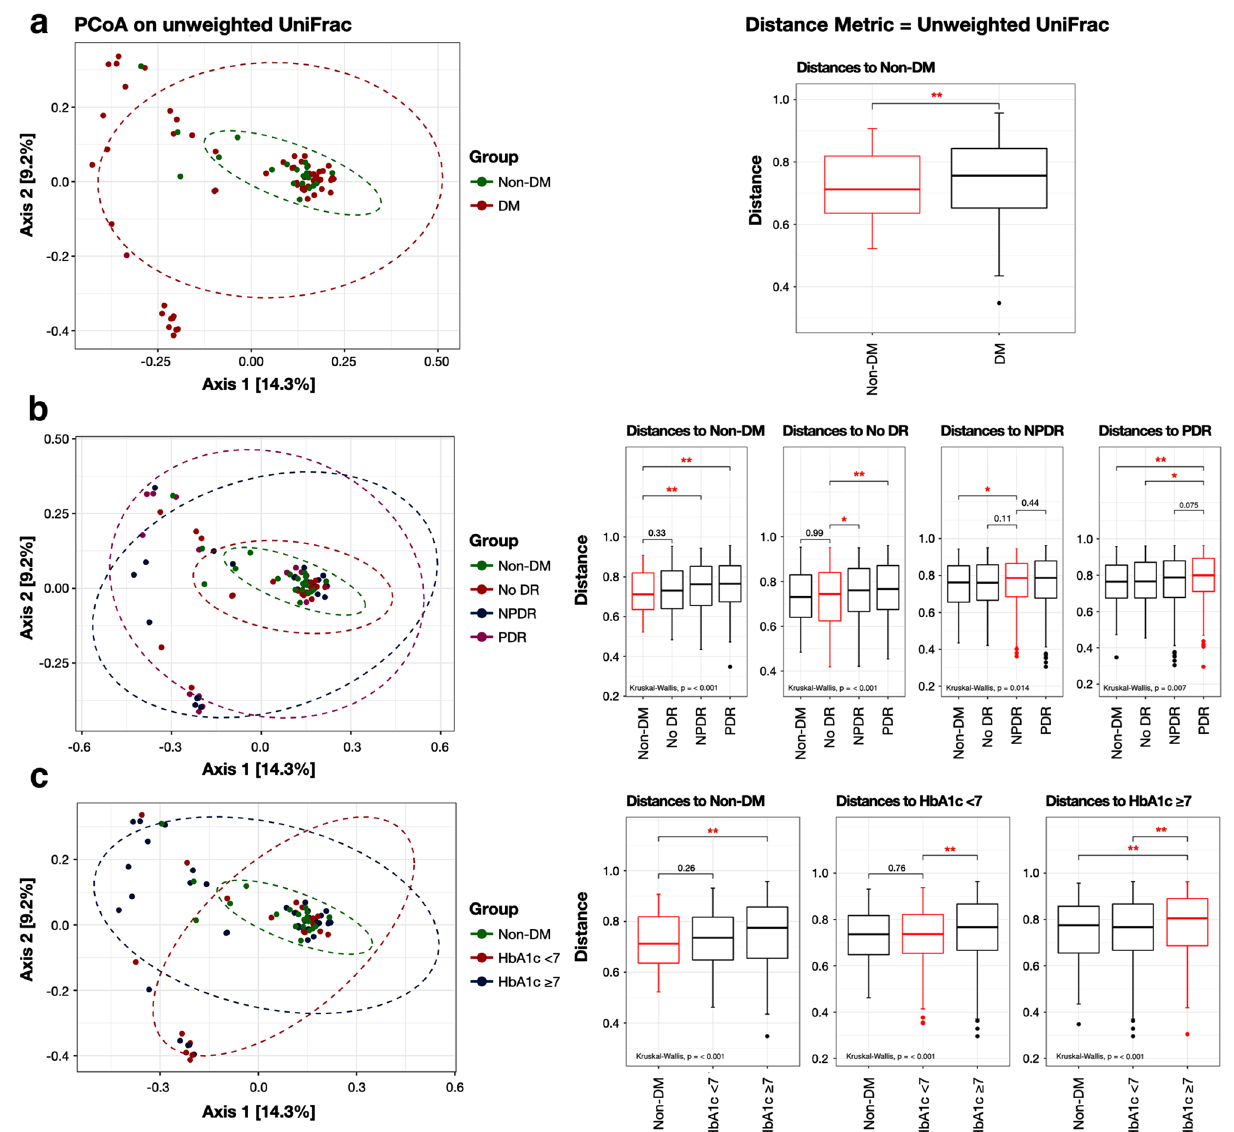
plot): ( a ) between the non-DM (green-dotted circle) and DM groups (red-dotted circle); ( b ) between the non-DM (green-dotted circle) and DM subgroups classified by the DR staging (no DR: red-dotted circle, NPDR: blue-dotted circle, and PDR: purple-dotted circle); and ( c ) between the non-DM (green-dotted circle) and DM subgroups classified by the glycemic control (HbA1c < 7%: red-dotted circle, HbA1c ≥ 7%: blue-dotted circle) (* p value < 0.05; ** p value < 0.001). (Abbreviations: DM diabetes mellitus, Non-DM non-diabetes mellitus, No DR no diabetic retinopathy, NPDR non-proliferative diabetic retinopathy, PDR proliferative diabetic retinopathy, HbA1c hemoglobin